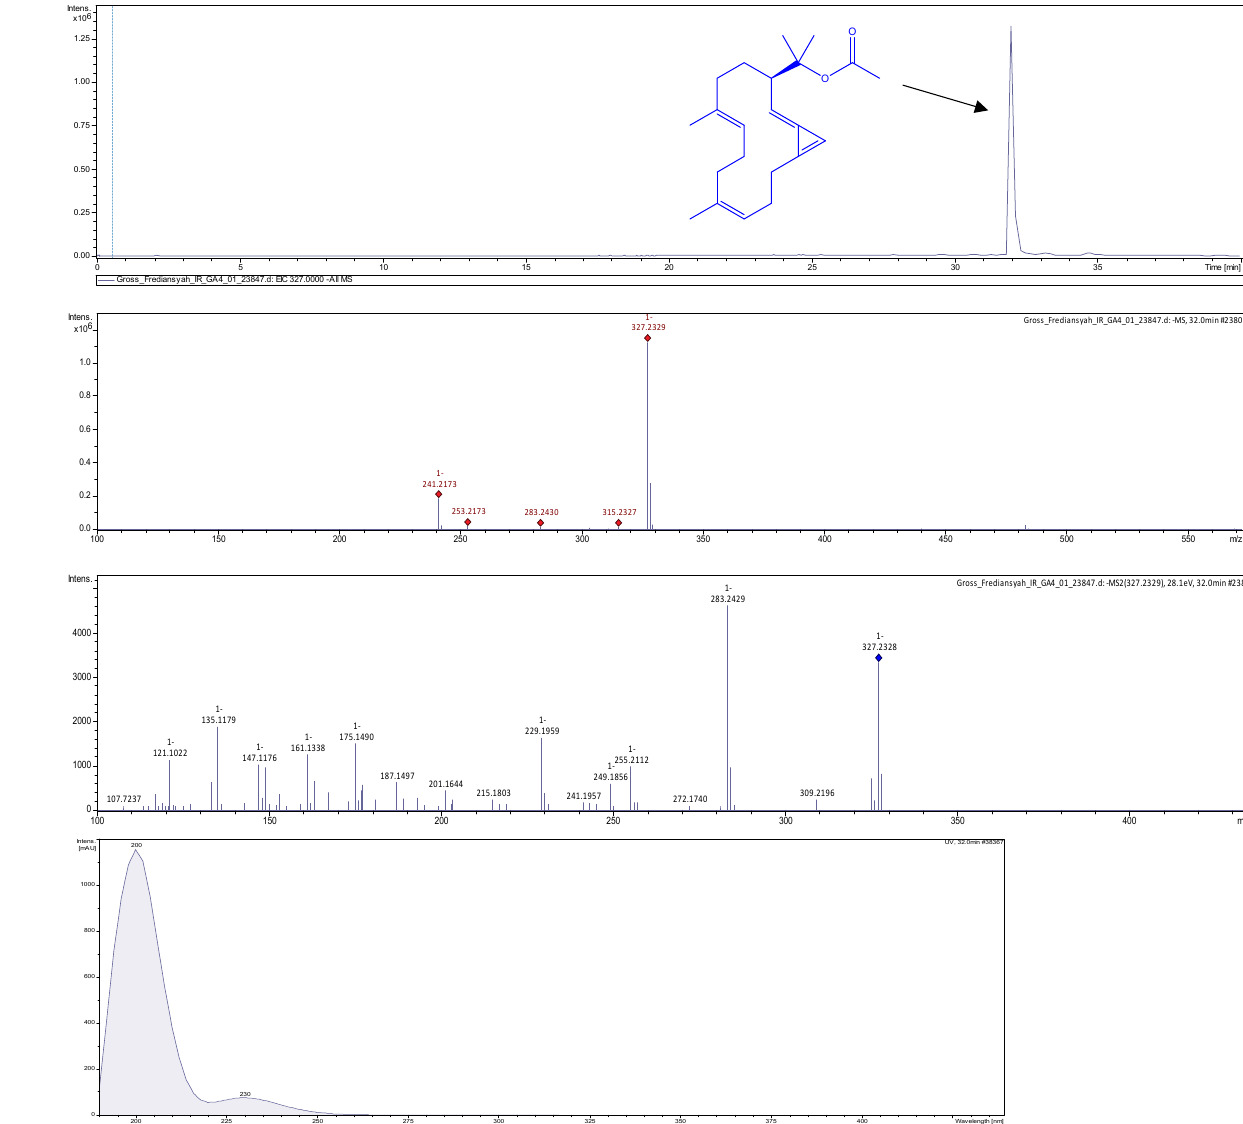
Figure 2. ESI-HR-TOF-MS analysis of putative brassicolene in GLE: ( A ) Extracted ion chromatogram and chemical structure of brassicolene (a m/z of 327.2339 [M-H] - ). ( B ) Negative mode MS 1 of brassicolene. ( C ) Negative mode MS 2 of brassicolene. ( D ) UV absorption in mass spectrometric analysis of